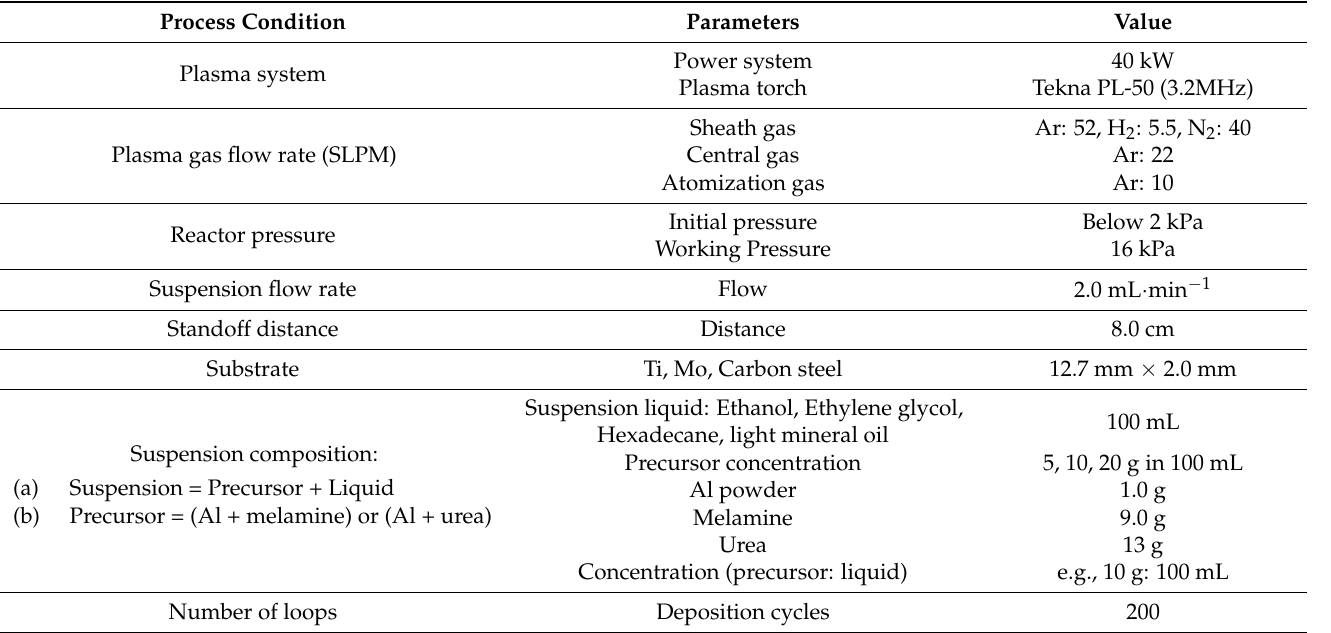
Table 4. Reaction conditions for the in situ production of plasma-synthesized AlN